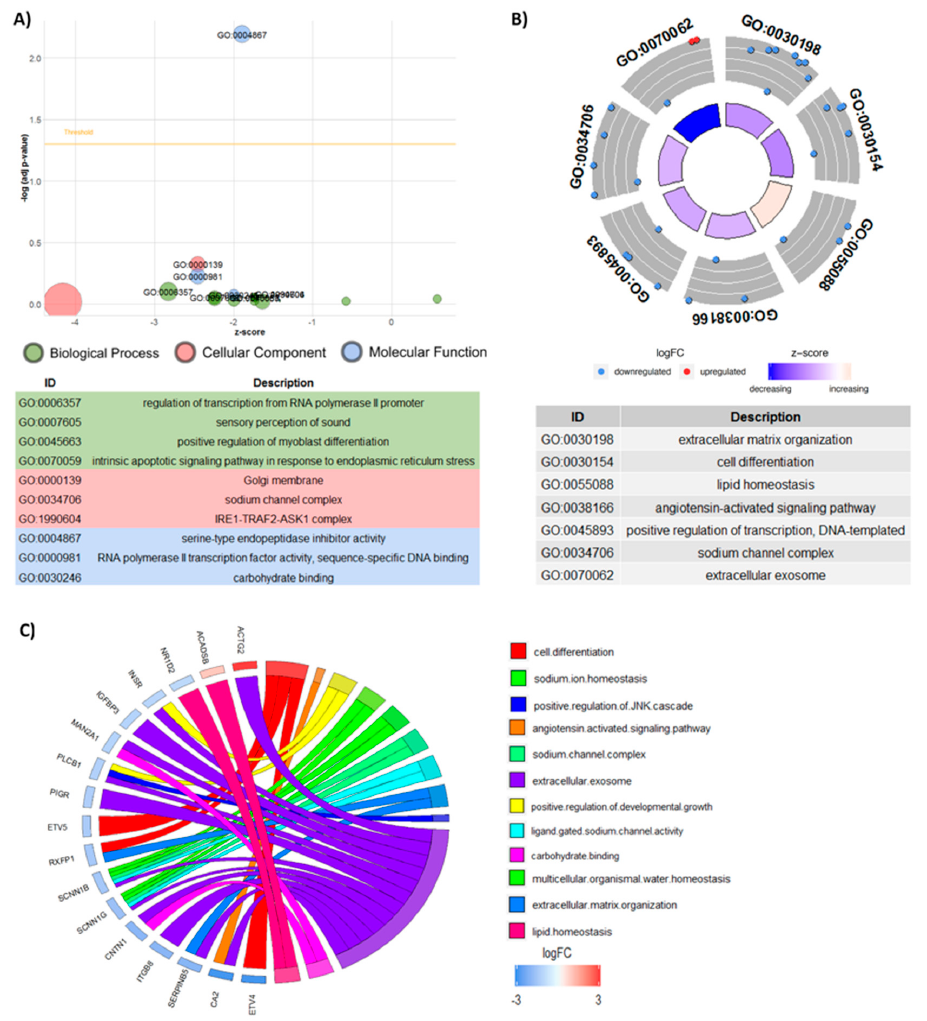
Figure 3. Gene ontology of differentially expressed genes analyzed by DAVID and the GOplot package. ( A ) GOBubble plot of differentially expressed genes analyzed by DAVID. The y-axis shows the –log10 (adjusted P -value) and the x-axis shows the z-score. The area of the circles is proportional to the number of genes related to the term. A threshold for the labeling is set based on the negative logarithm of the adjusted p -value. The Biological Process, Cellular Component and Molecular Function are represented by green, pink and blue, respectively. The identification (ID) and description of each term is given. ( B ) GOCircle plot showing the number of genes in each GO term. The inside rings are a bar plot, with the height representing the significance of the term (-log10 adjusted P -value). Different colors of the inside rings represent the z-score, with blue showing a decrease and red an increase. The outside rings show the expression levels (logFC) for each gene in the GO term. Each dot in the outside rings represents one gene from the GO term, red dots show upregulated genes and blue dots show downregulated genes. ( C ) GOChord plot show genes linked by ribbons to their respective GO terms and the logFC of each gene. The colored squares next to each gene represent the logFC, with red showing positive logFC, blue showing negative logFC and white showing no change. Each GO Term is assigned a color corresponding to the color of the ribbon indicating the relationship with the